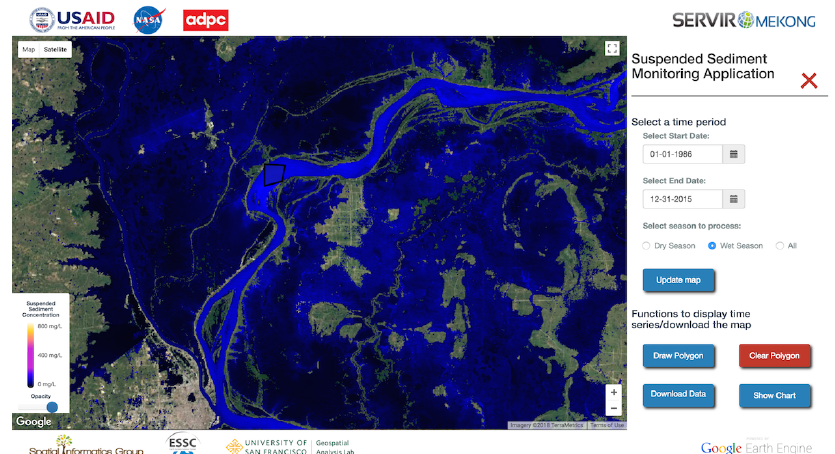
Figure 7. A screenshot of the Mekong Suspended Sediment Monitoring web application (https: //mekong-ssc.appspot.com). To download a dataset, users set their desired parameters in the right panel. The region of interest can be a polygon drawn directly on the map. A mean composite for the time period is processed on the fly and is available for users to download